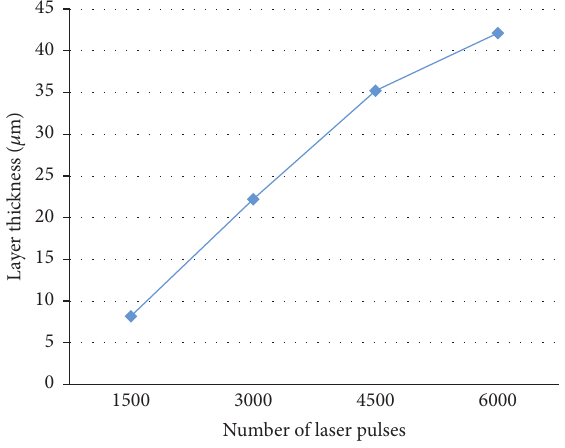
Figure 3: Film thickness versus number of pulses.